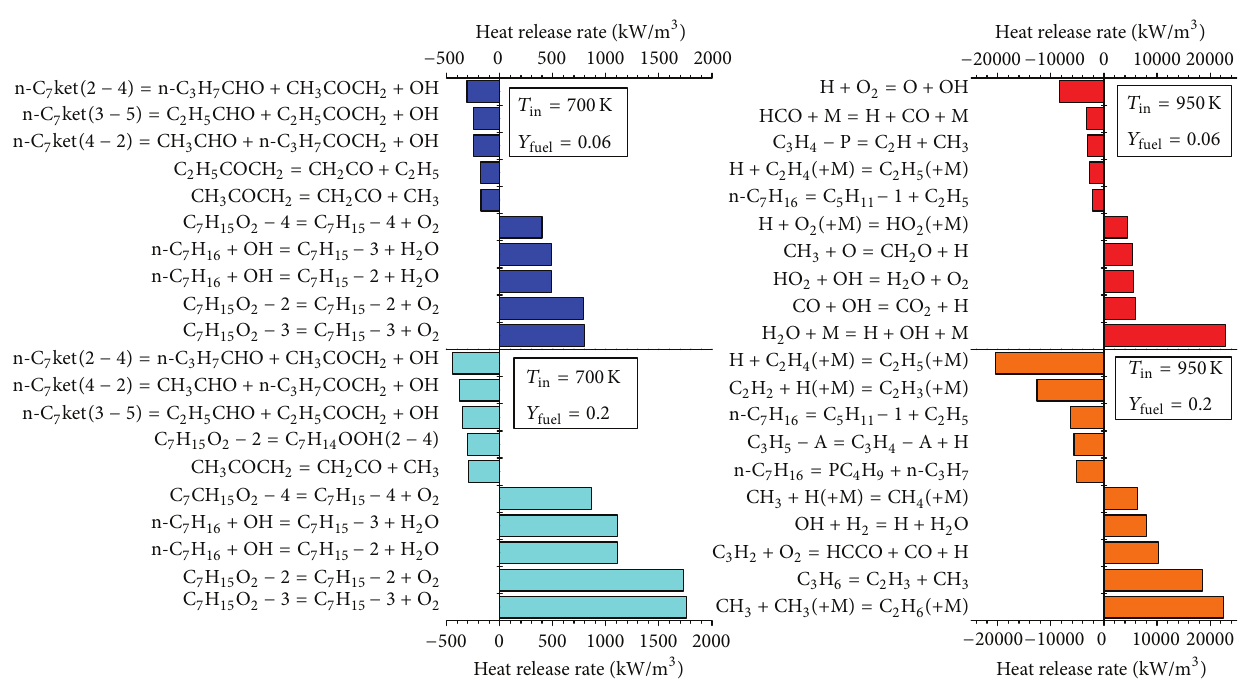
Figure 10: Predictions of heat release rate per unit volume for the reactions exhibiting maximum absolute endothermic and exothermic = 5 values ( 𝑡 res